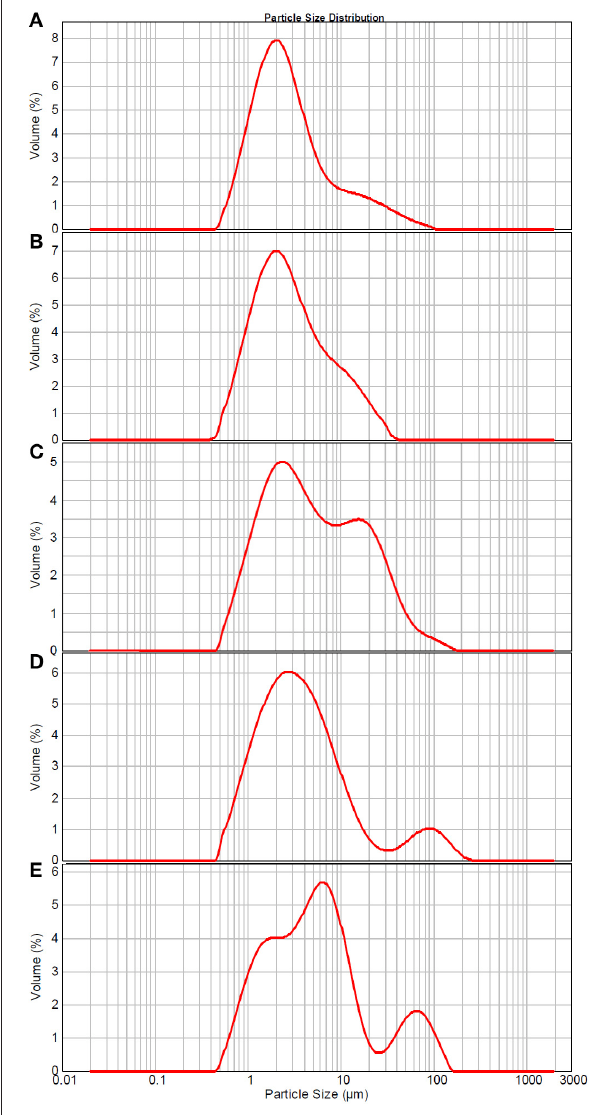
FIGURE 2 | Size distribution of TCPs in tuna head soup at different boiling times. (A) 5min; (B) 15min; (C) 30min; (D) 60min; and (E)